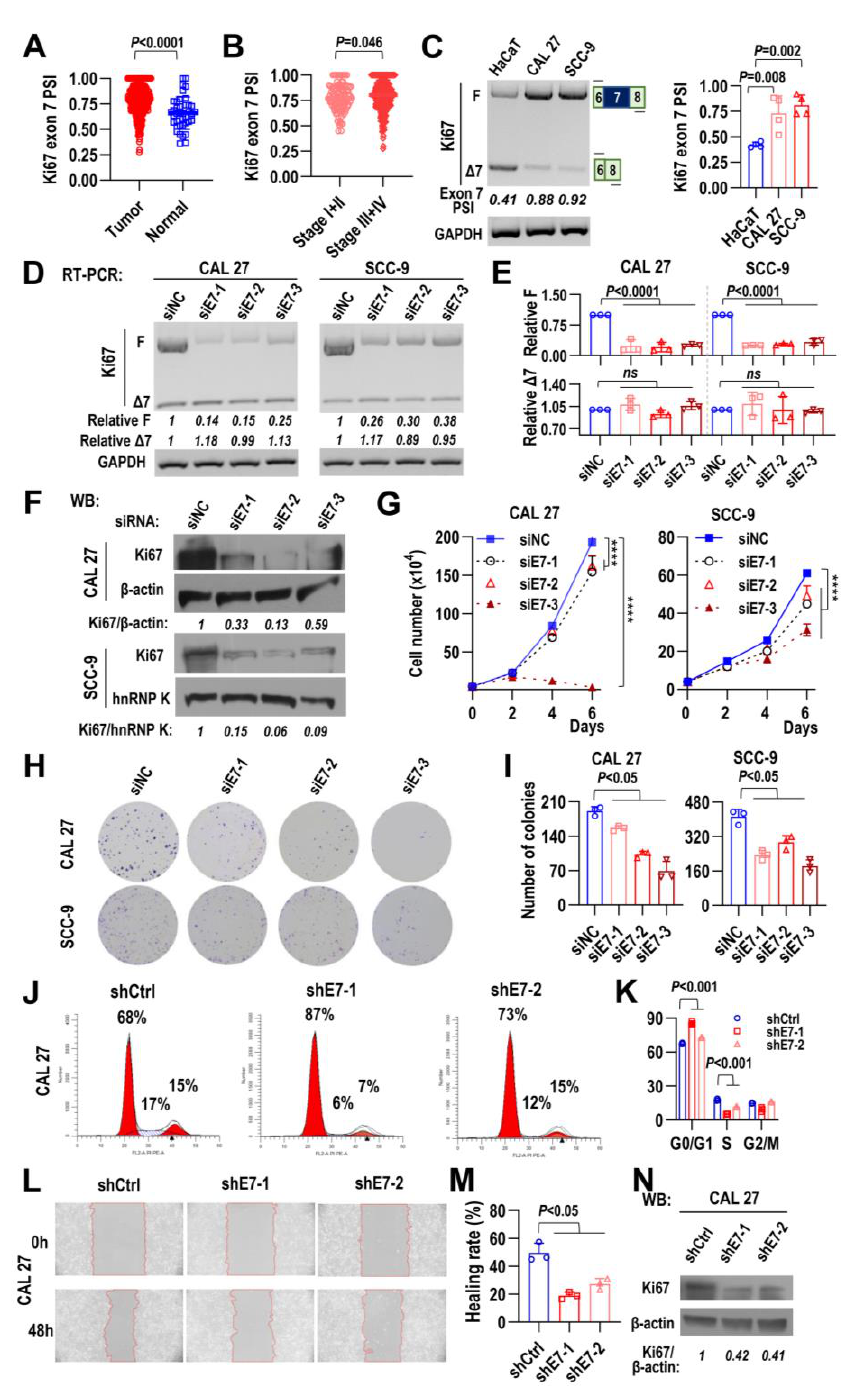
Figure 2. Ki67 exon 7 inclusion is required for HNSCC cell proliferation, cell cycle progression, and cell migration. ( A ) Comparison of the inclusion level of Ki67 exon 7 (PSI) between normal and tumor tissues in TCGA HNSCC dataset. ( B ) Comparison of Ki67 exon 7 PSI between patients in stage I+II and those in stage III + IV from TCGA HNSCC dataset. ( C ) Alternative splicing of Ki67 exon 7 in HaCaT (normal), CAL 27, and SCC-9 (OSCC cancer) cell lines was analyzed by RT-PCR. GAPDH served as a loading control. Diagrams on the right show the structures of Ki67 exon 7-spliced products. The histogram represents the quantification result. PSI is calculated as F/(F + Δ7). ( D – I ) CAL 27 and SCC-9 cells were treated with siE7s (Ki67 exon 7 targeted siRNAs) or siNC (nonspecific siRNA). ( D ) The knockdown efficiency of full-length Ki67 with exon 7 in oral cancer cells was ana- lyzed by RT-PCR. GAPDH served as a loading control. ( E ) The histograms summarize the expres- sion levels of Ki67 full-length isoform with or without exon 7. ns represents p > 0.05. ( F ) Western